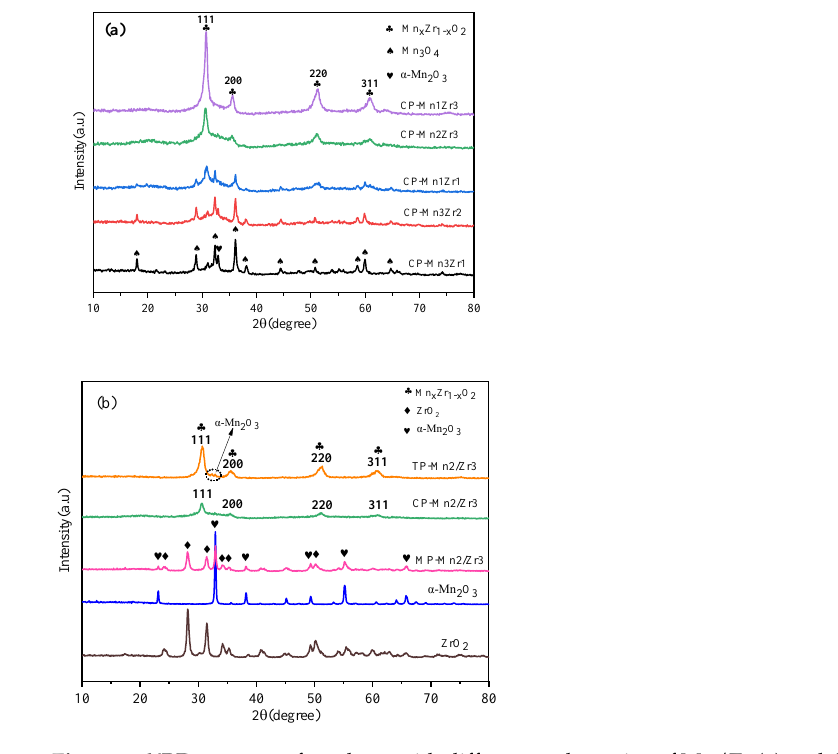
Figure 1. XRD patterns of catalysts with different molar ratios of Mn/Zr ( a ) and different preparation routes ( b ) (two-step precipitation (TP); conventional coprecipitation (CP); ball milling process